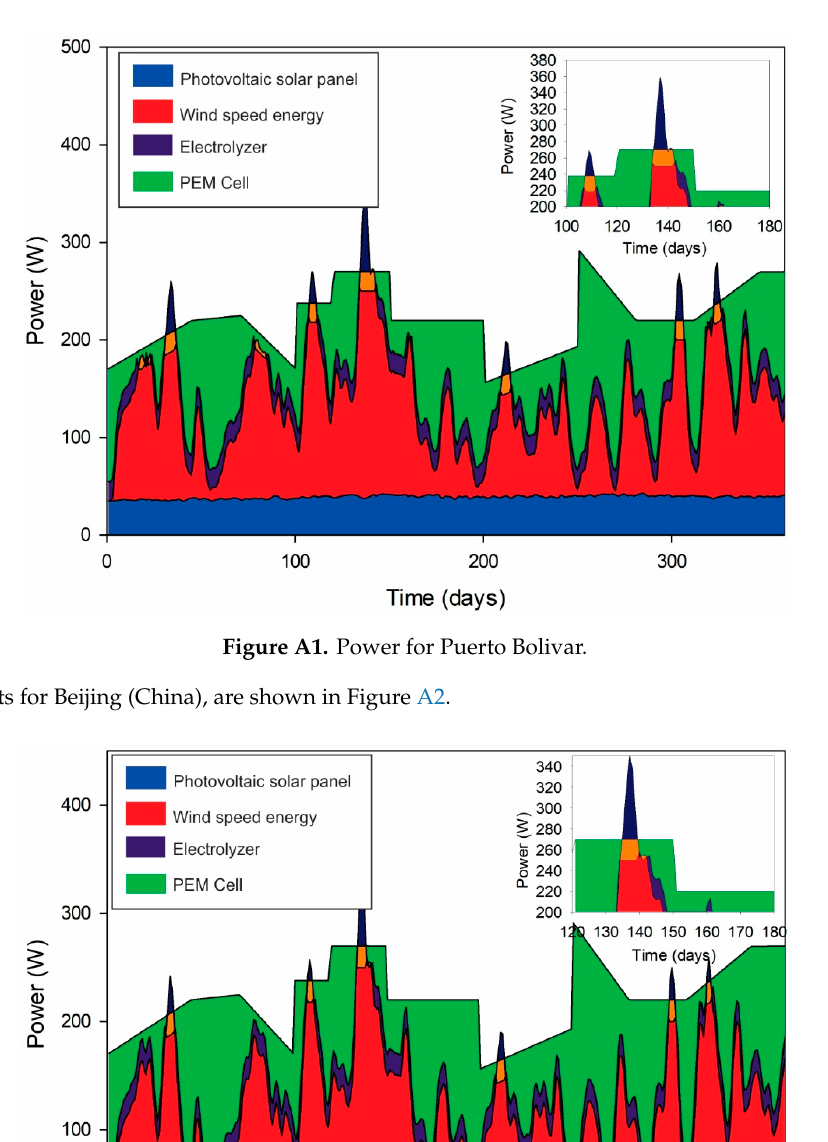
(PEM) fuel cell model. Table 2. Proton exchange membrane